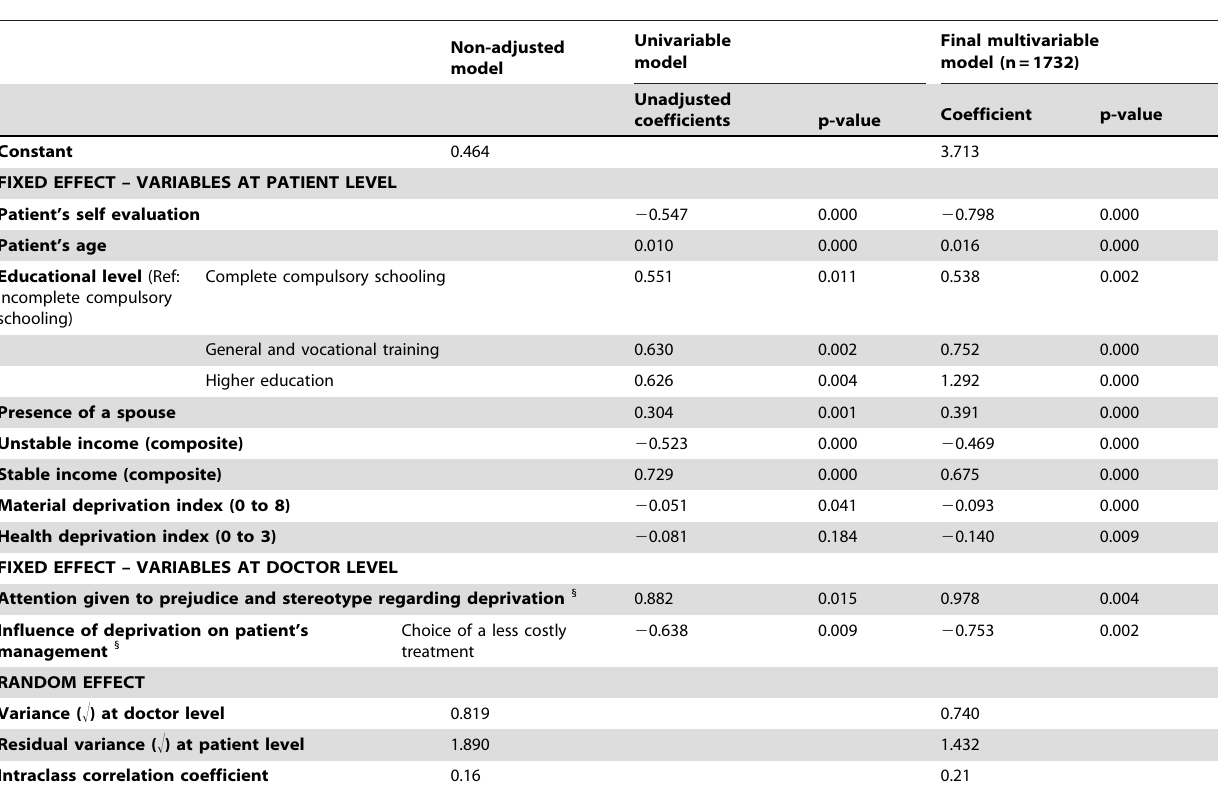
Table 6. Multivariable analysis of the difference between GP and patient evaluation of patient social